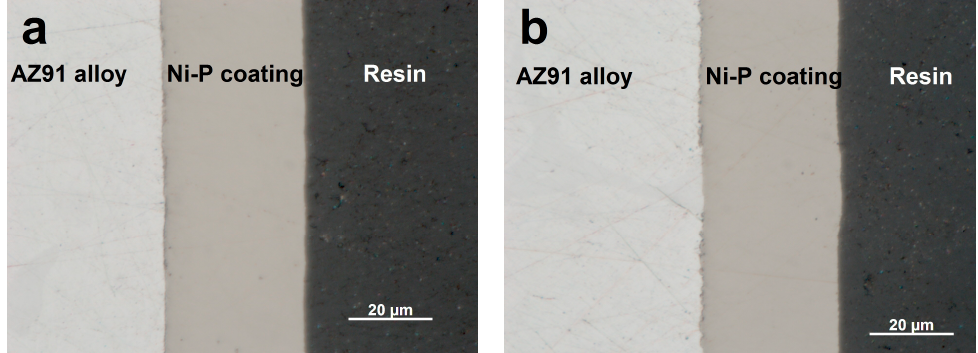
Figure 1. Microstructure of Ni–P coatings with 7.4 wt.% P ( a ) as-deposited; ( b ) heat-treated.